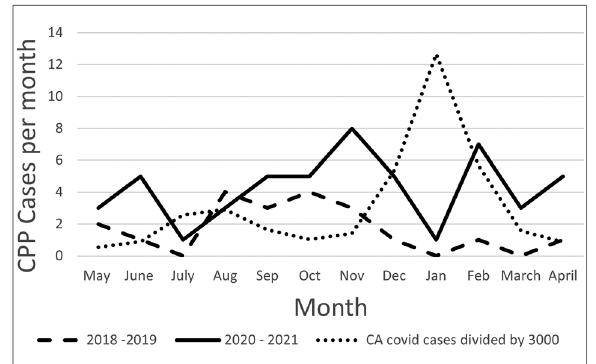
FIGURE 1 CPP cases by month of diagnosis. Dashed line represents pre- pandemic, solid line represents Covid-19, dotted line represents Covid cases in California divided by 3,000 for visual scaling.